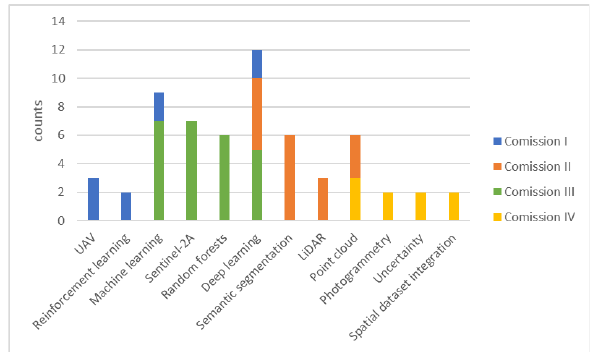
Figure 1. The four most frequent keywords extracted from papers in the annals of Commission I-IV of ISPRS Conference 2021. For the sake of clearness only one notation for the keywords is selected.